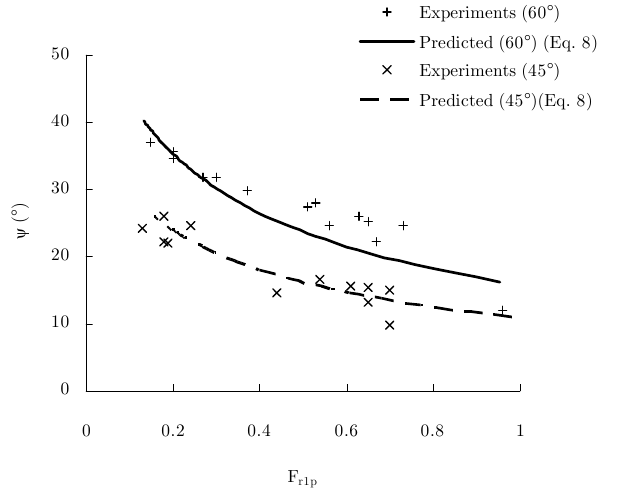
Fig. 15. Flow direction on the weir crest versus Froude number at the centre of the weir crest.